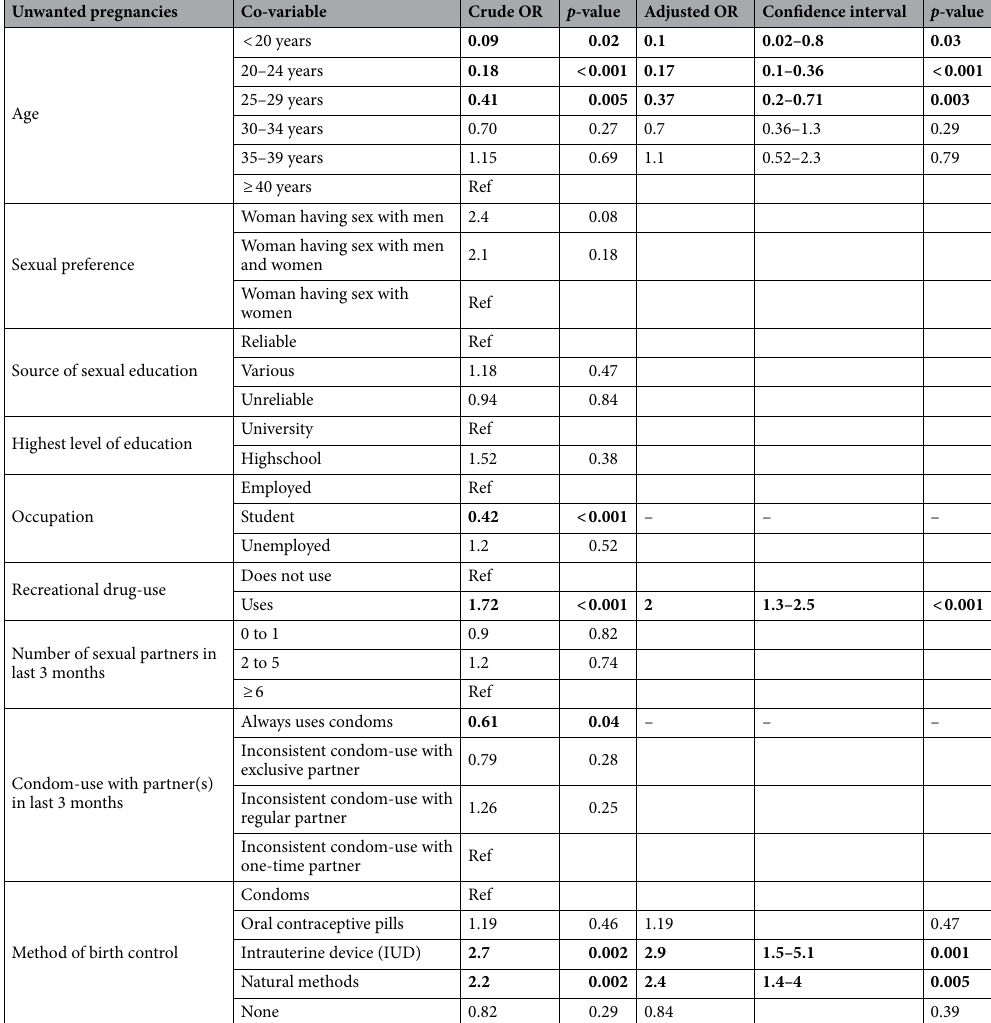
Table 5. Binomial regression model for unwanted pregnancies with crude and adjusted odds ratios (ORs). Significant results are in bold